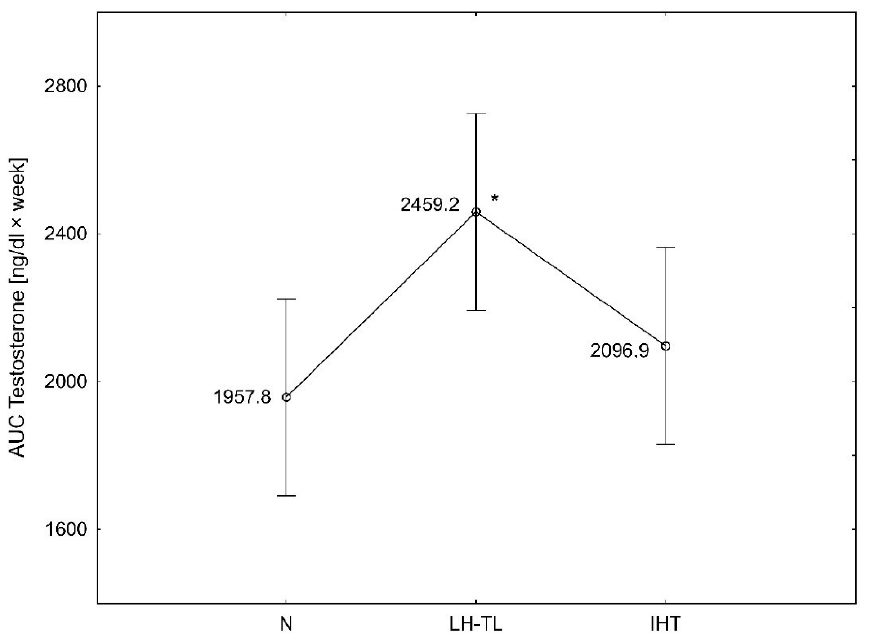
Figure 4. Area under the curve (AUC) calculated from testosterone levels over 4 weeks in experimental (LH–TL and IHT) and control (N) groups; * p < 0.05—statistically significant differences.